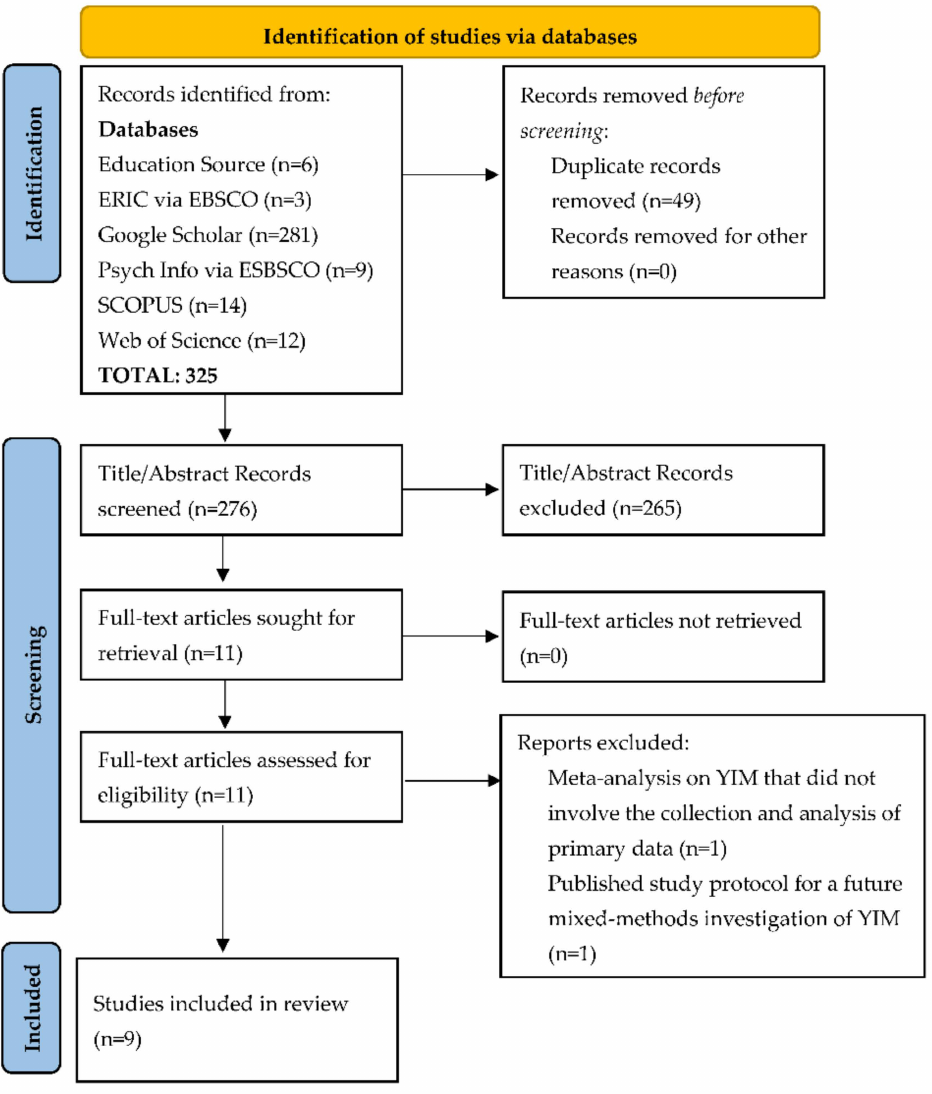
Figure 1. Flow Diagram of Scoping Review Search Strategy and